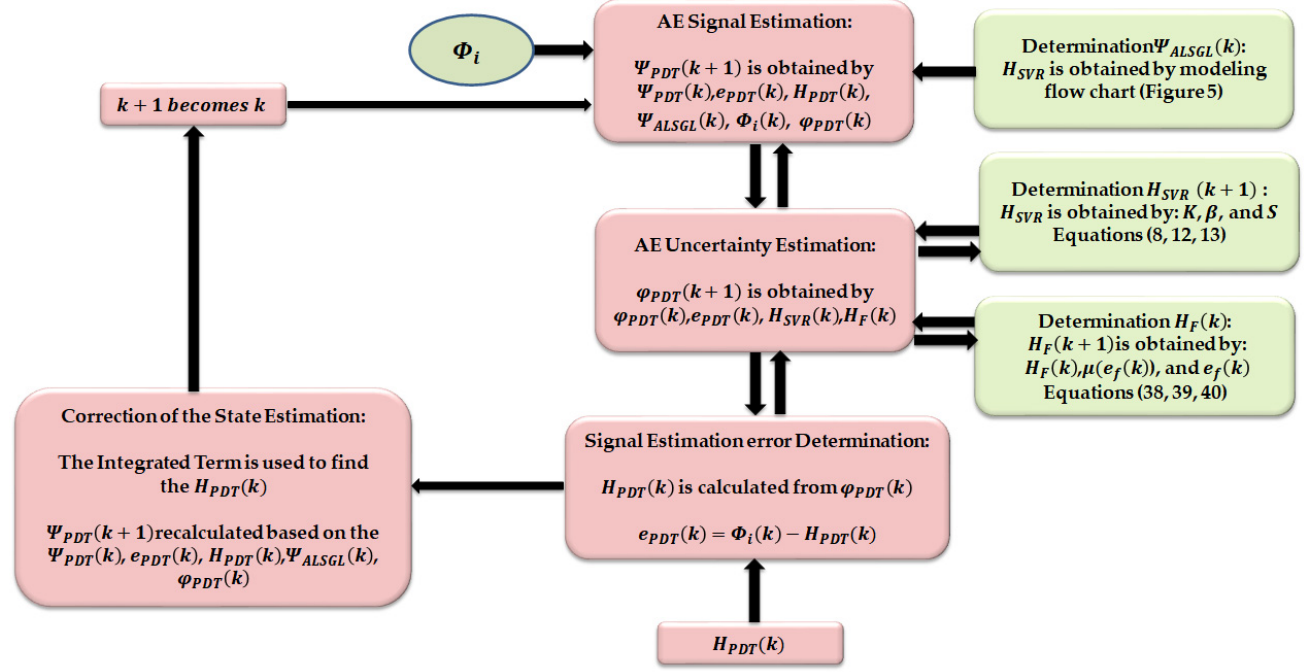
Figure 6. Flow chart typical of AE signal estimation using proposed digital twin.